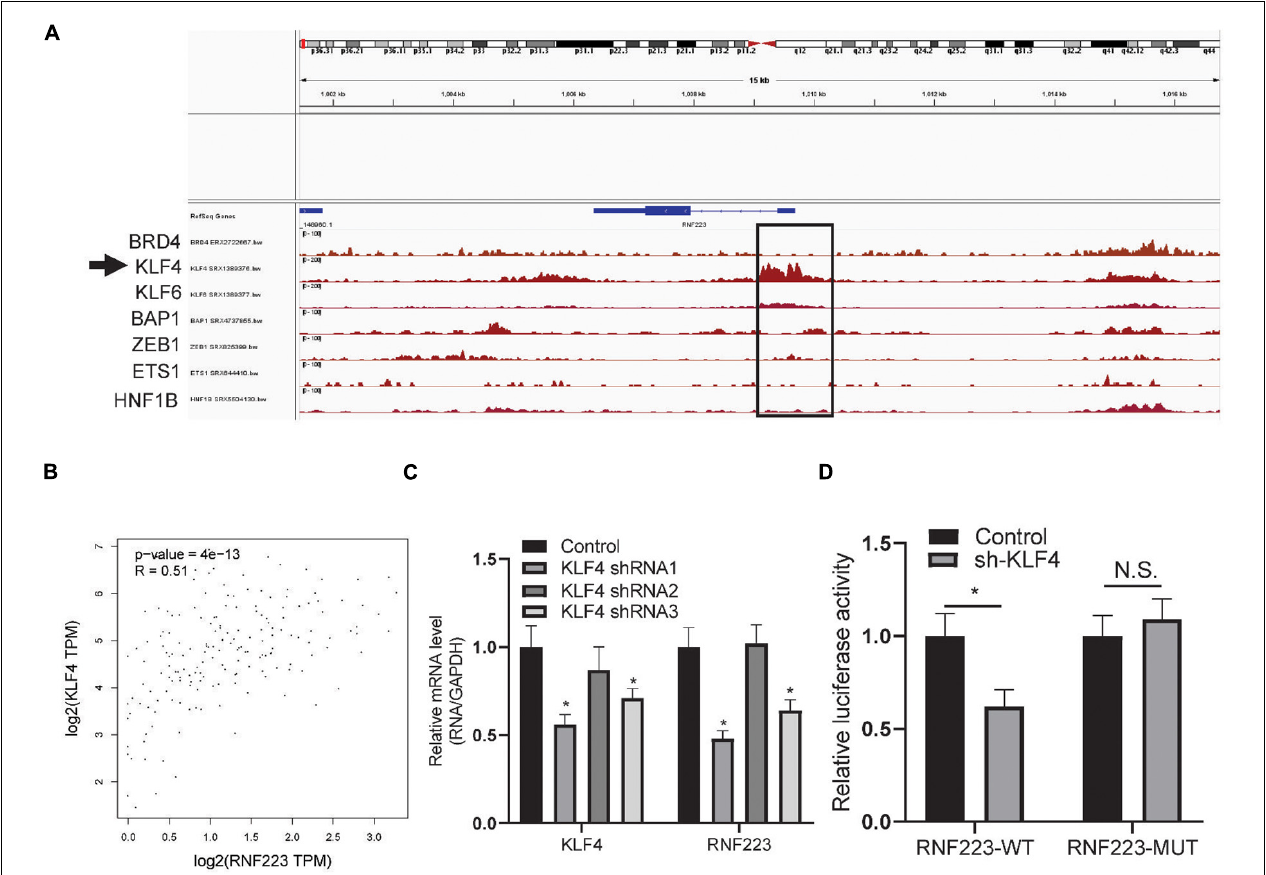
FIGURE 7 | RNF223 is transcriptionally activated by KLF4 in pancreatic cancer. (A) Binding peaks of transcription factors in pancreatic cancer tissue and cell lines; arrow indicates that KLF4 shows remarkable binding affinity at the promoter of RNF223. (B) Expression correlation of KLF4 with RNF223 in the TCGA PAAD dataset. (C) Relative expression of KLF4 and RNF223 in KLF4 knockdown shRNA-transfected ASPC-1 cell lines. (D) Luciferase assay showing the binding affinity of KLF4 in RNF223 promoter WT and mutated (MUT) cells. All assays were conducted using three replicates and * p < 0.05.